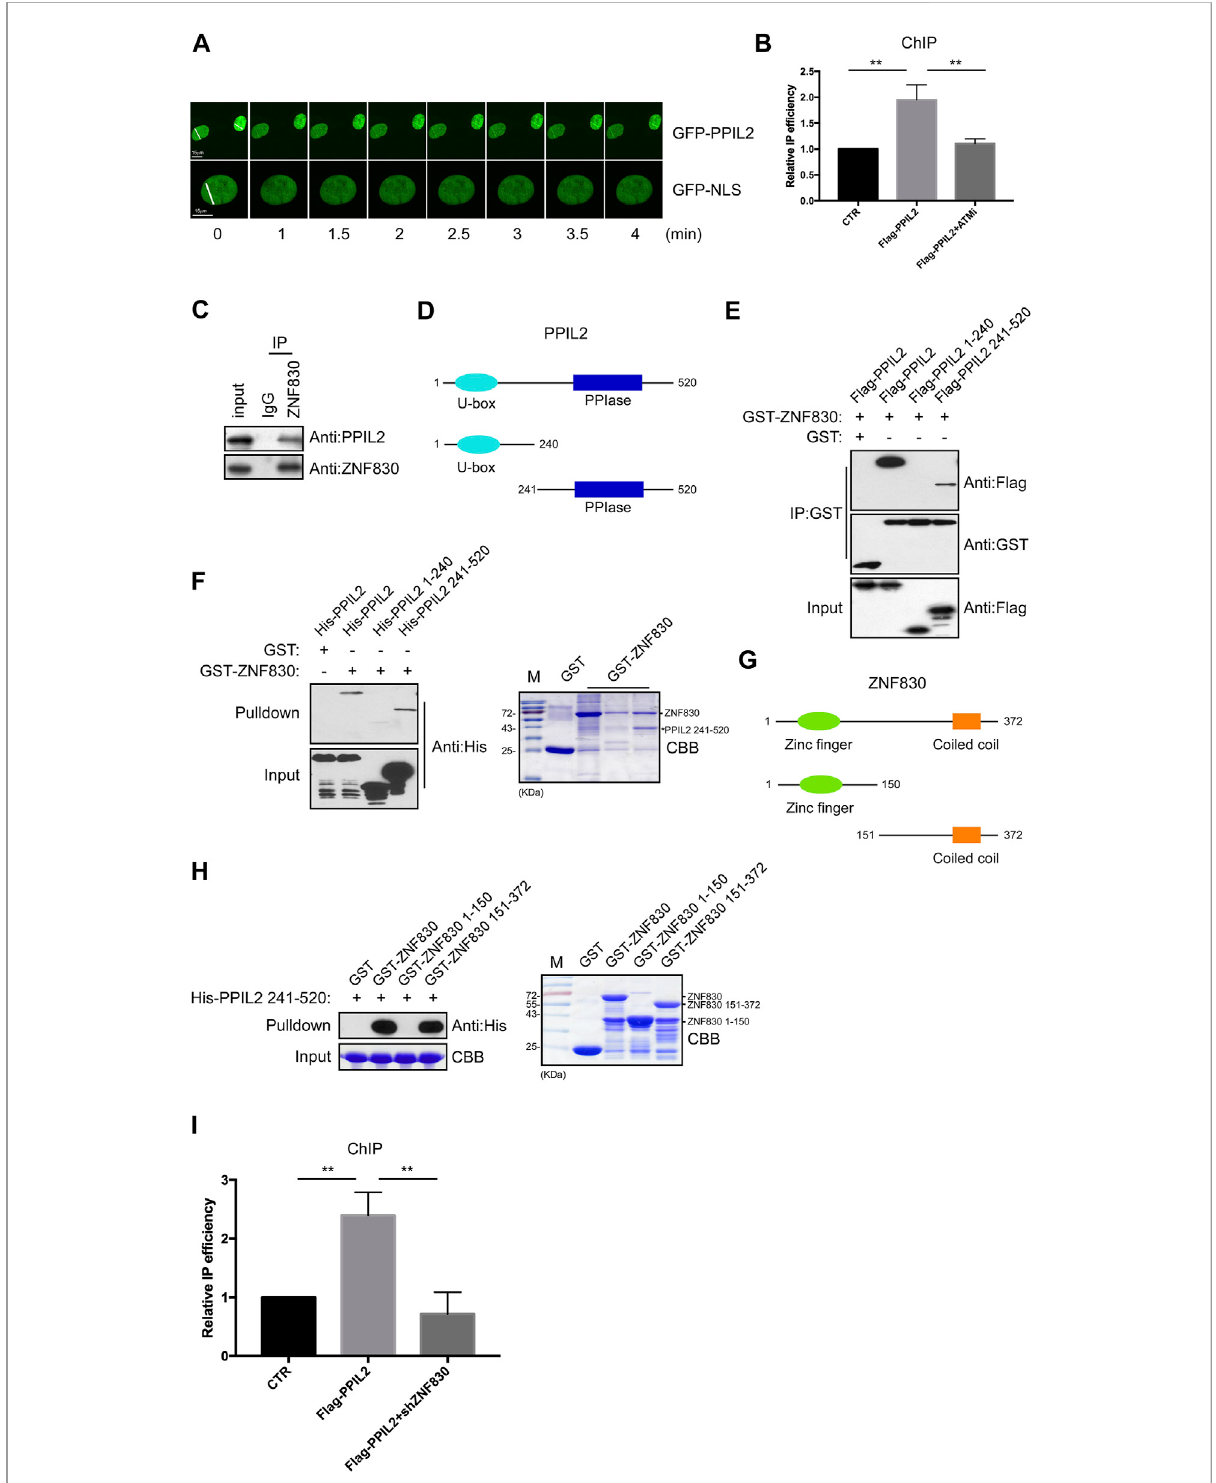
FIGURE 1 PPIL2 is recruited to DNA damage sites and interacts with ZNF830. (A) Live-cell imaging of recruitment showed that EGFP-PPIL2 localied to DSBs induced in U2OS cells by laser microirradiation. EGFP-PPIL2 was expressed in U2OS cells. (B) PPIL2 enrichment at DSBs. ChIP assay was performed in ER- Asi SI U2OS cells were treated with 4-OHT (300 nM) for 4 h, using Flag M2 besds IP Flag-vector (CTR) or Flag-PPIL2. ChIP ef fi ciencies were measured by qPCR from Asi SI induced DSBs. ER- Asi SI U2OS cells were treated with ATM inhibitor (ATMi) KU-55933 (20 μ M,